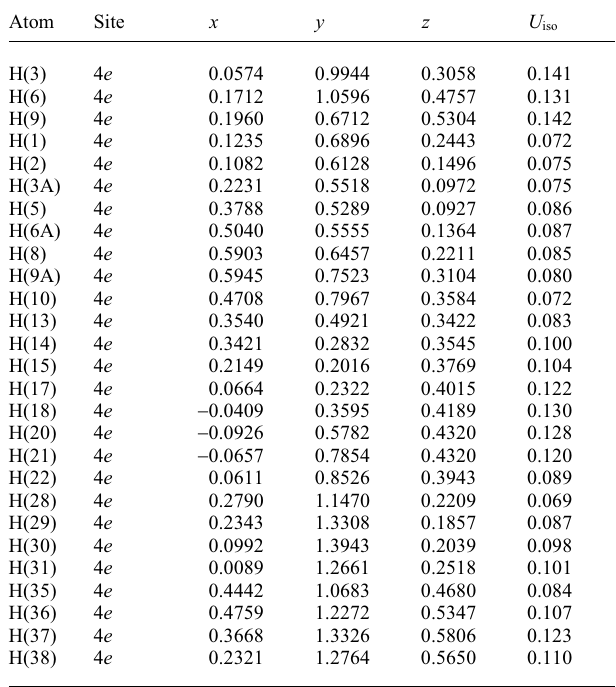
Table 2. Atomic coordinates and displacement parameters (in Å 2 )